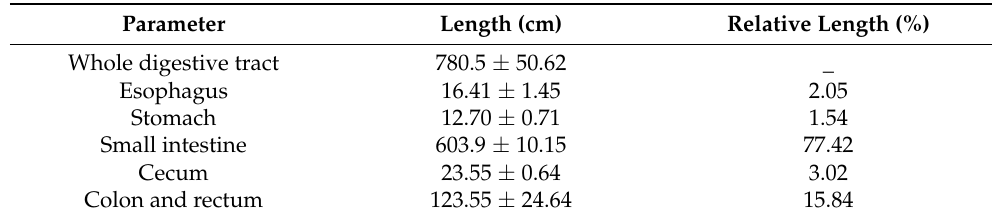
Table 1. The length (cm) and relative length (%) of various segments of the gastrointestinal tract of adult male D. leporina. ( n =